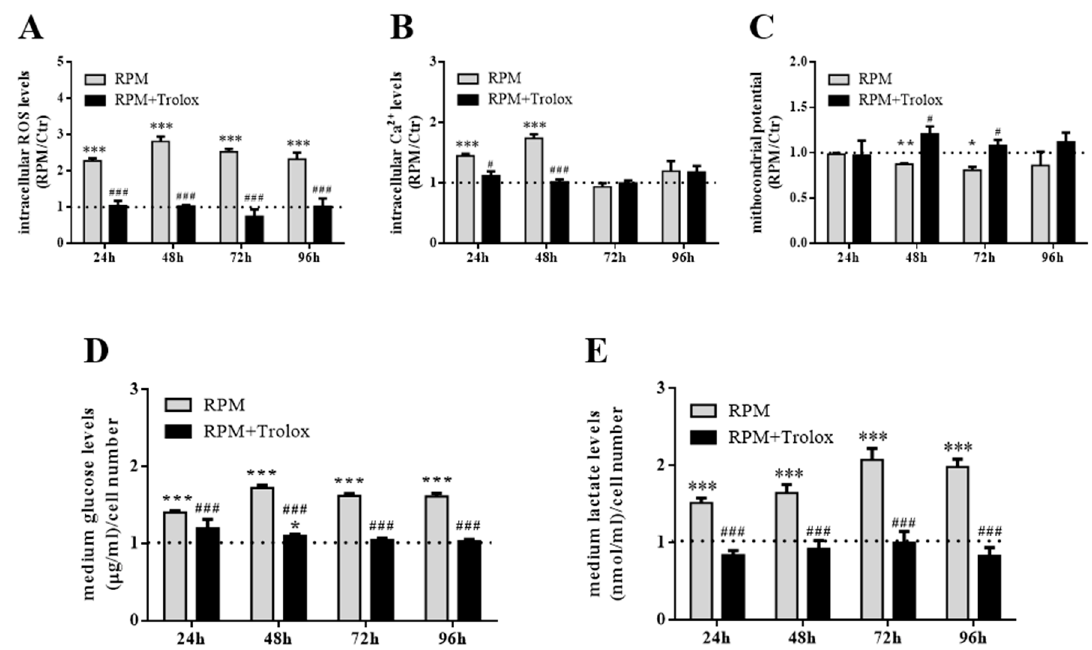
Figure 4. Antioxidant supplementation as countermeasure to s-microgravity. ( A – C ) Intracellular ROS, Ca 2 + levels and mitochondrial membrane potential in live cells exposed to s-microgravity up to 96 h without (RPM) or with Trolox (RPM + Trolox). ( D , E ) Glucose and lactate levels measured in growth medium of cells exposed to RPM, in absence of RPM, or presence of 100 µ M Trolox (RPM + Trolox). The data in the graphs are presented as the ratio between each parameter and the respective control (dashed line) at each time point, and are the means ± SEM from three independent experiments. * p < 0.05, ** p < 0.01, *** p < 0.001 vs. respective Controls ; # p < 0.05, ### p < 0.001 vs. RPM + DMSO . See the complete data sets and detailed statistical analyses, reported in Supplementary Tables (Tables S1–S5).